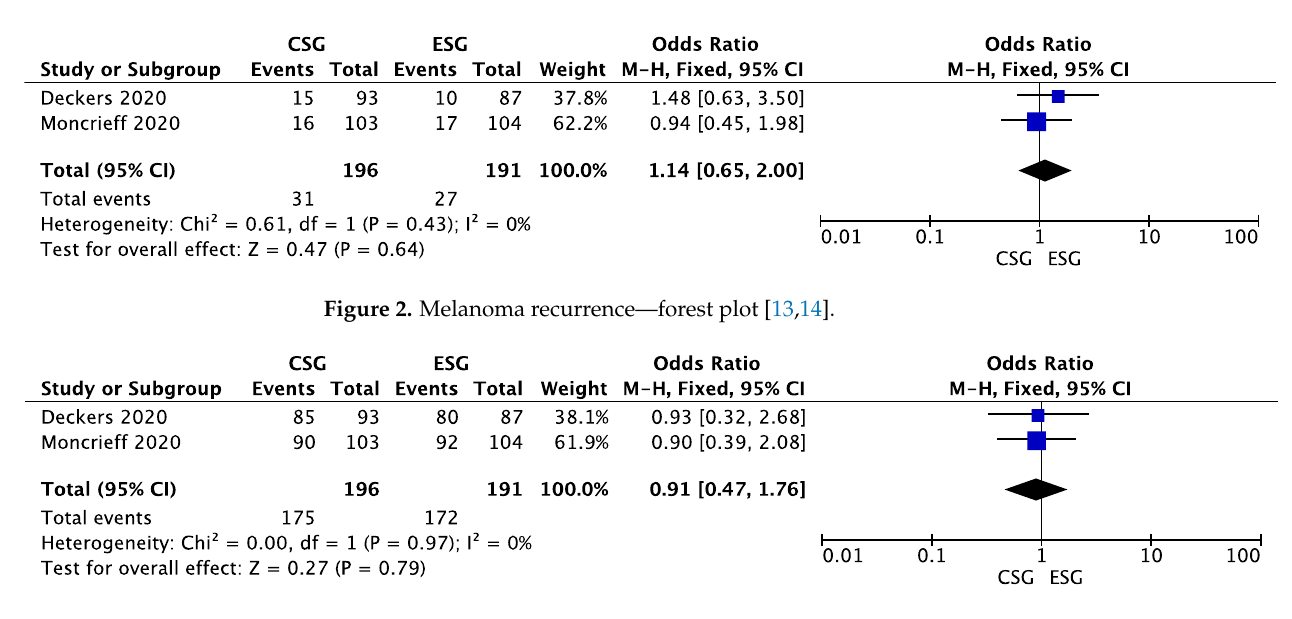
Figure 3. 3-year melanoma survival—forest plot.